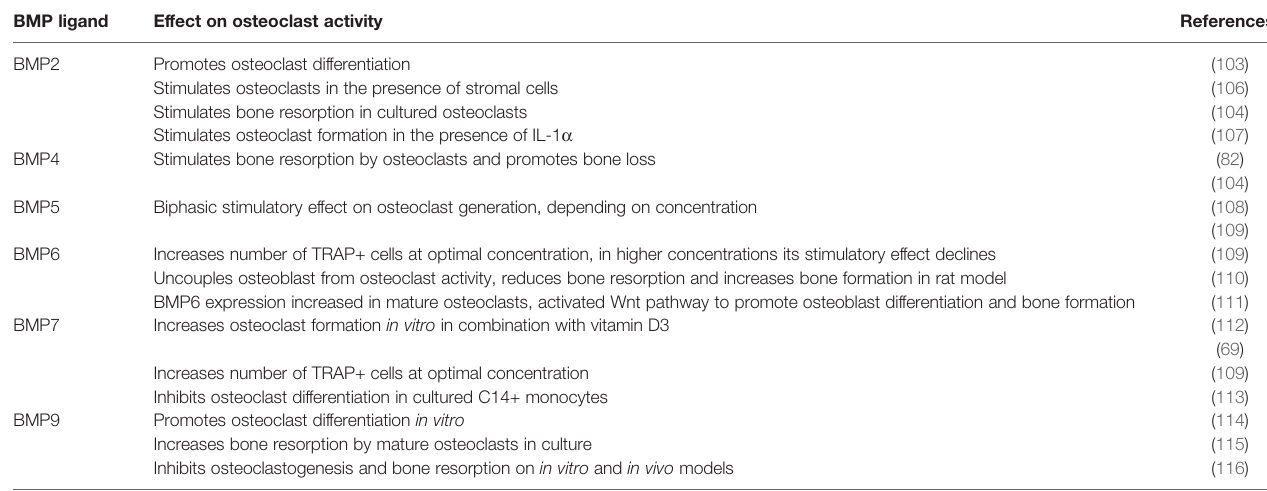
TABLE 2 | An overview of BMP action on osteoclasts.